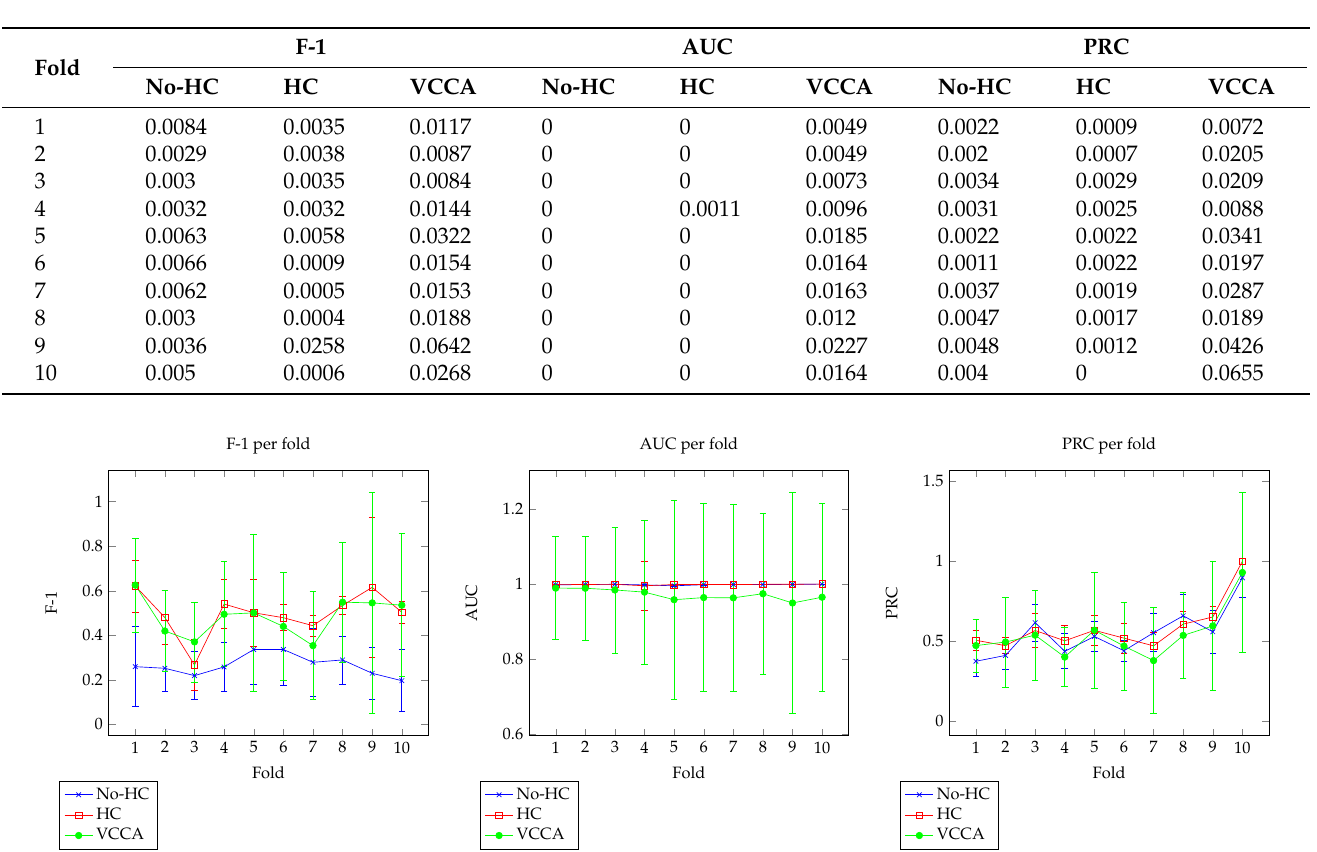
Table 11. The Variance of Metrics from Dataset 2.